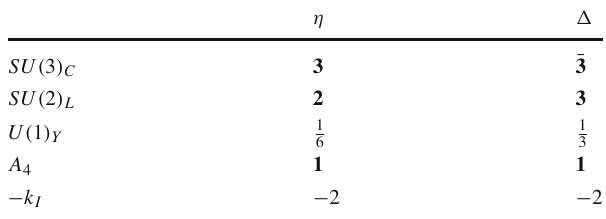
Table1 ChargeassignmentsoftheLQbosons η and (cid:6) under SU ( 3 ) C × SU ( 2 ) L × U ( 1 ) Y × A 4 where k I is the number of modular